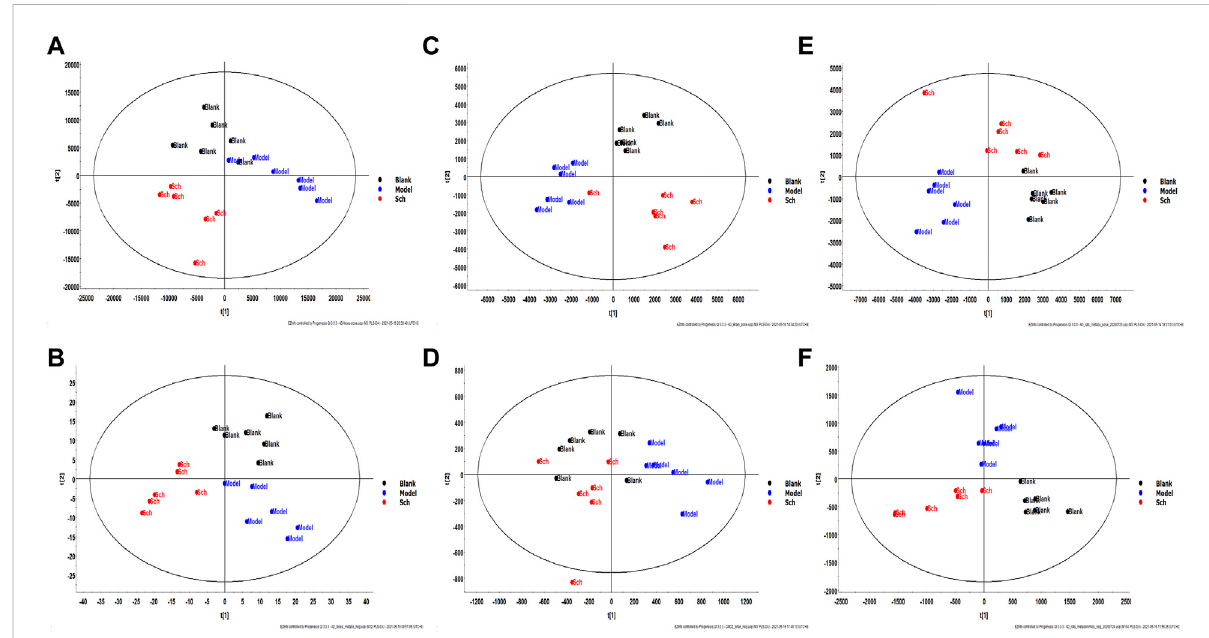
FIGURE 4 Multivariate statistical analysis fi gure of PLS-DA: (A) feces sample in positive mode; (B) feces sample in negative mode; (C) brain sample in positive mode; (D) brain sample in negative mode; (E) plasma sample in positive mode; and (F) plasma sample in negative